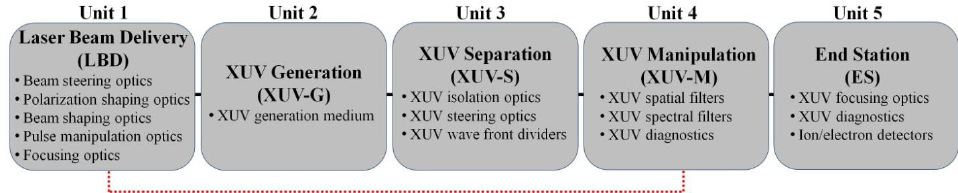
Figure 7. Block diagram of gas and solid surface asec sources.